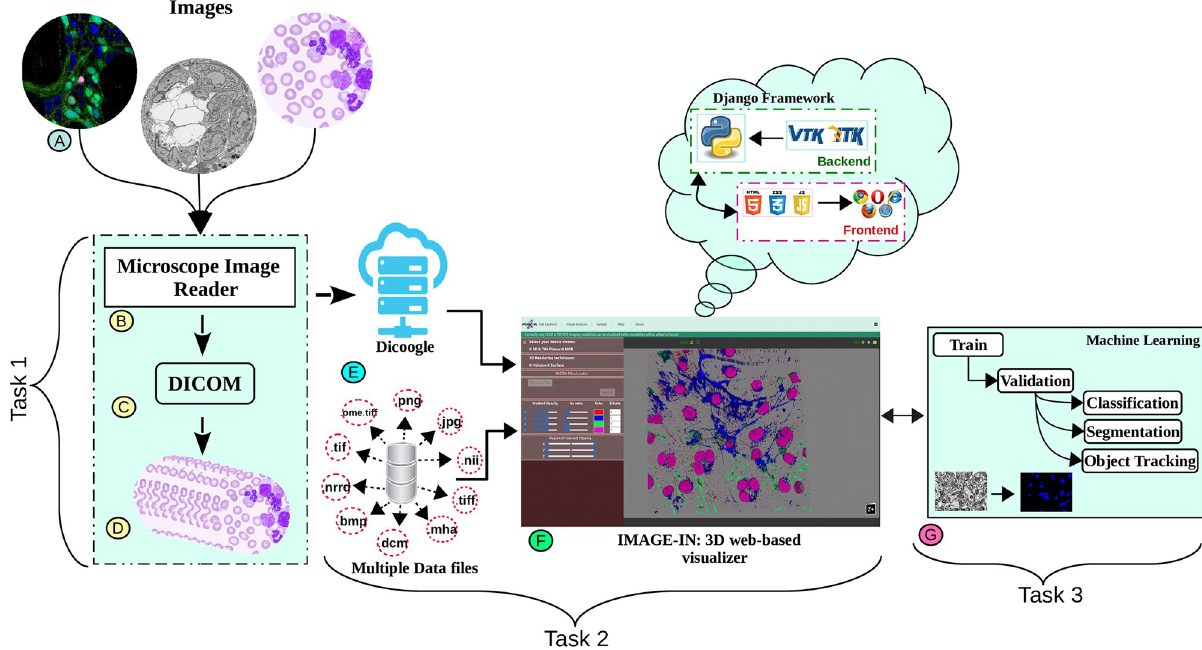
Fig 1. The overall framework. Task-1 includes the development of a pipeline for converting proprietary high-resolution microscope imaging modalities data into DICOM standard format. Task-2 includes the development of a 3D multidimensional high-resolution microscope image viewer. Task-3 includes the development of automatic content discovery for microscope imaging modalities, specifically CLSM and FIB-SEM